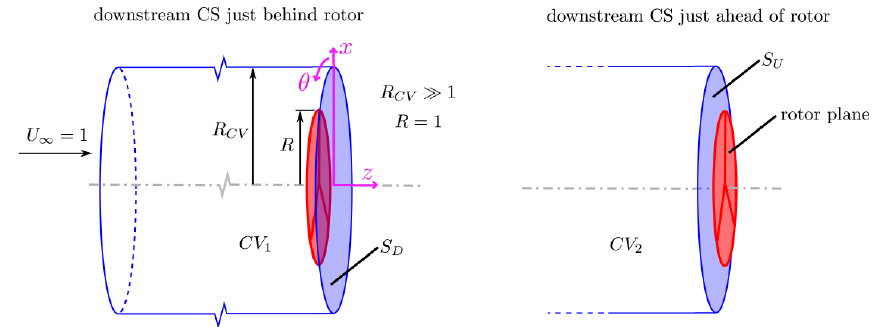
Figure 1. Control volumes (CVs) to be used in the present analysis. In both variants, the upstream face extends in z to −∞ , where the velocity is the wind speed, and R CV (cid:29) R . The downstream control surface is just downstream and just upstream of the rotor plane in CV 1 and CV 2 , respectively, and the corresponding downstream control surfaces (CS) are labelled S D and S U . Taken from LW.